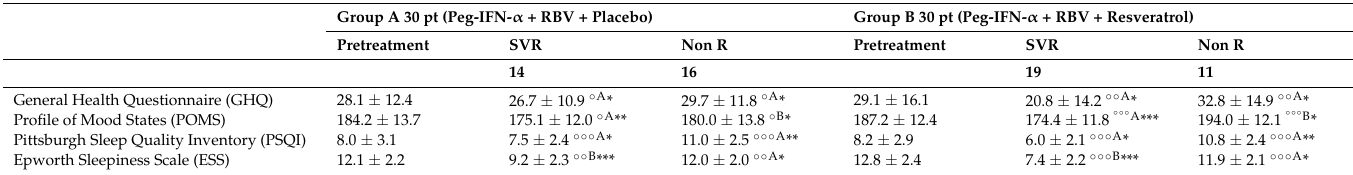
SVR: Sustained Viral Response; Non R: Non Responders; Comparison within groups: * NS; ** p < 0.05; *** p < 0.001; Comparison SVR-Non R within groups: ◦ NS; ◦◦ p < 0.05; ◦◦◦ p < 0.001; Comparison between groups: A NS; B p < 0.05; C p < 0.001; There were no significant differences between groups at